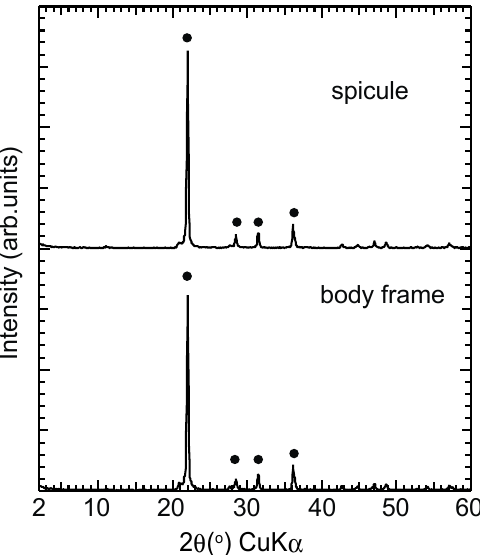
Figure 12. The XRD patterns for the sponge samples after TG-DTA measurements. Solid circle is the peak of cristobalite [47].